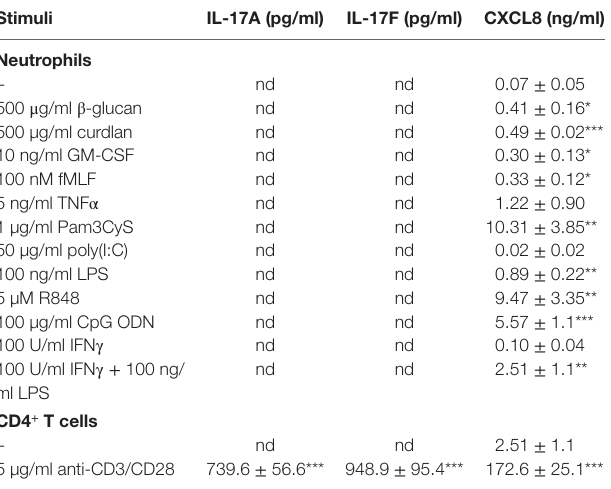
TaBle 1 | Lack of IL-17A and IL-17F production by activated human neutrophils.